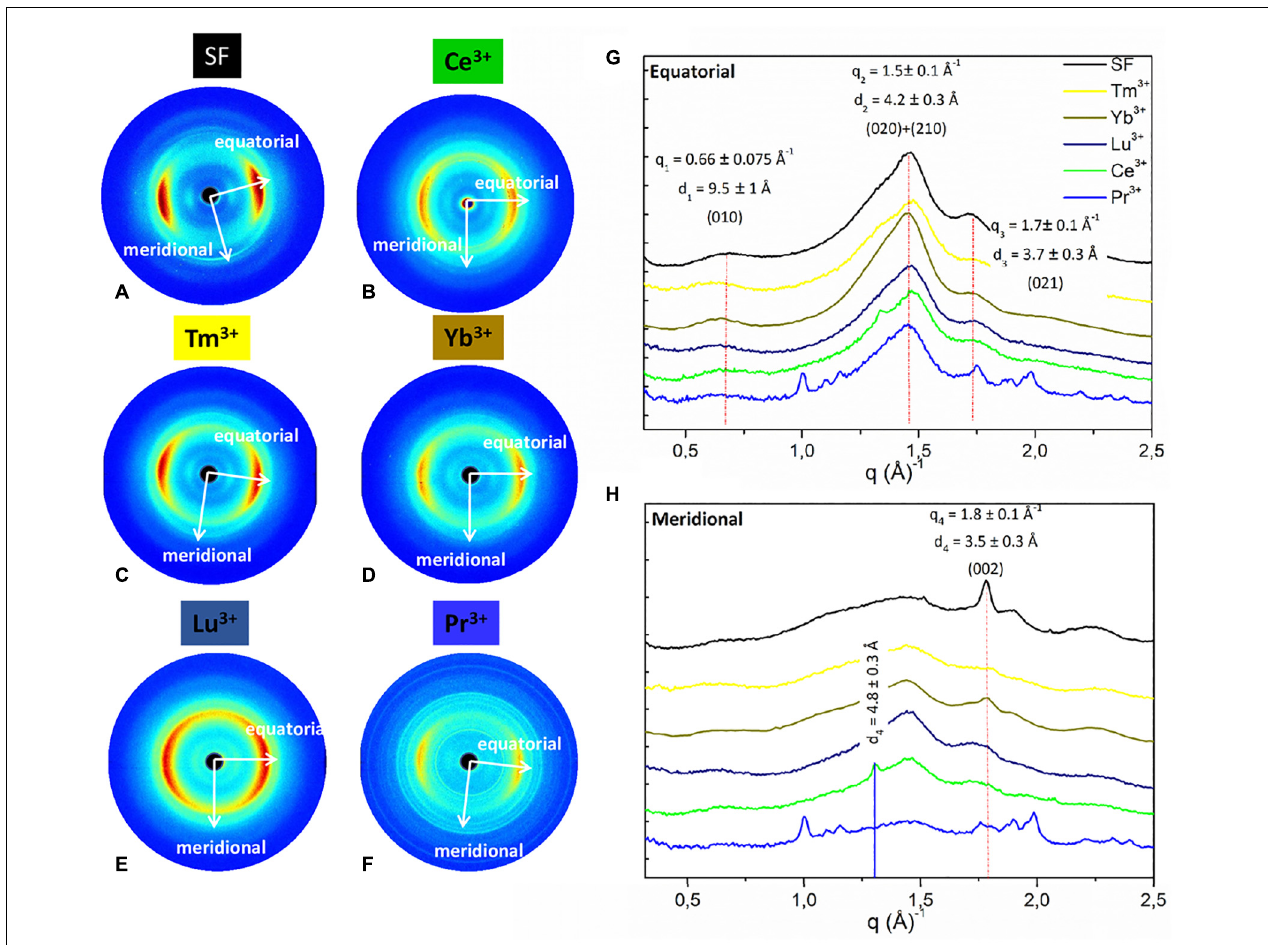
FIGURE 4 | 2D WAXS patterns of (A) degummed SF and regenerated fibers obtained after treatment with (B) Ce + 3 (C) Tm + 3 ; (D) Y + 3 ; (E) Lu + 3 ; (F) Pr + 3 , respectively, corresponding 1D (G) equatorial patterns and (H) meridional patterns. Vertical bars highlight the equatorial reflections at q 1 = 0.66 ± 0.075 Å − 1 (d 1 = 9.5 ± 1 Å), q 2 = 1.5 ± 0.1 Å − 1 (d 2 = 4.2 ± 0.3 Å), and q 3 = 1.7 ± 0.1 Å − 1 (d 3 = 3.7 ± 0.3 Å) and the meridional reflection at q 4 = 1.8 ± 0.1 Å − 1 (d 4 = 3.5 ± 0.2 Å) shifted at q 4 = 1.3 ± 0.1 Å − 1 (d 4 = 4.8 ± 0.2 Å) only for Ce + 3 . The equatorial and meridional peaks were indexed as follows: q 1 the (010) reflection;